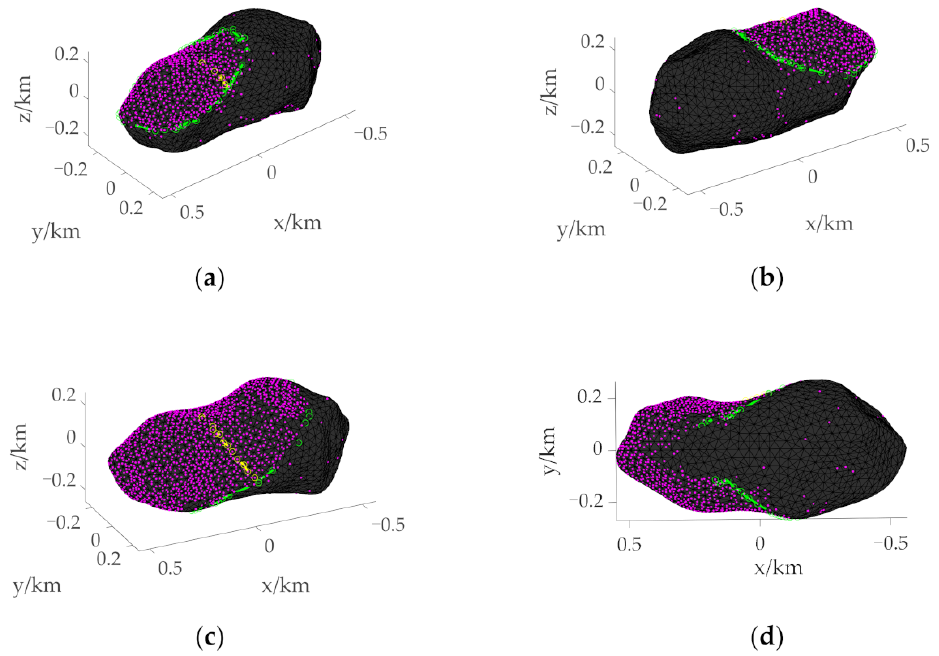
Figure 10. Initial boundary when the initial position is above the mid-latitude region. ( a ) 3D view of the initial boundary with t f = 900 s. ( b ) Supplementary view of the initial boundary with t f = 900 s. ( c ) 3D view of the initial boundary with t f = 1000 s. ( d ) Supplementary view of the initial boundary with t f = 1000